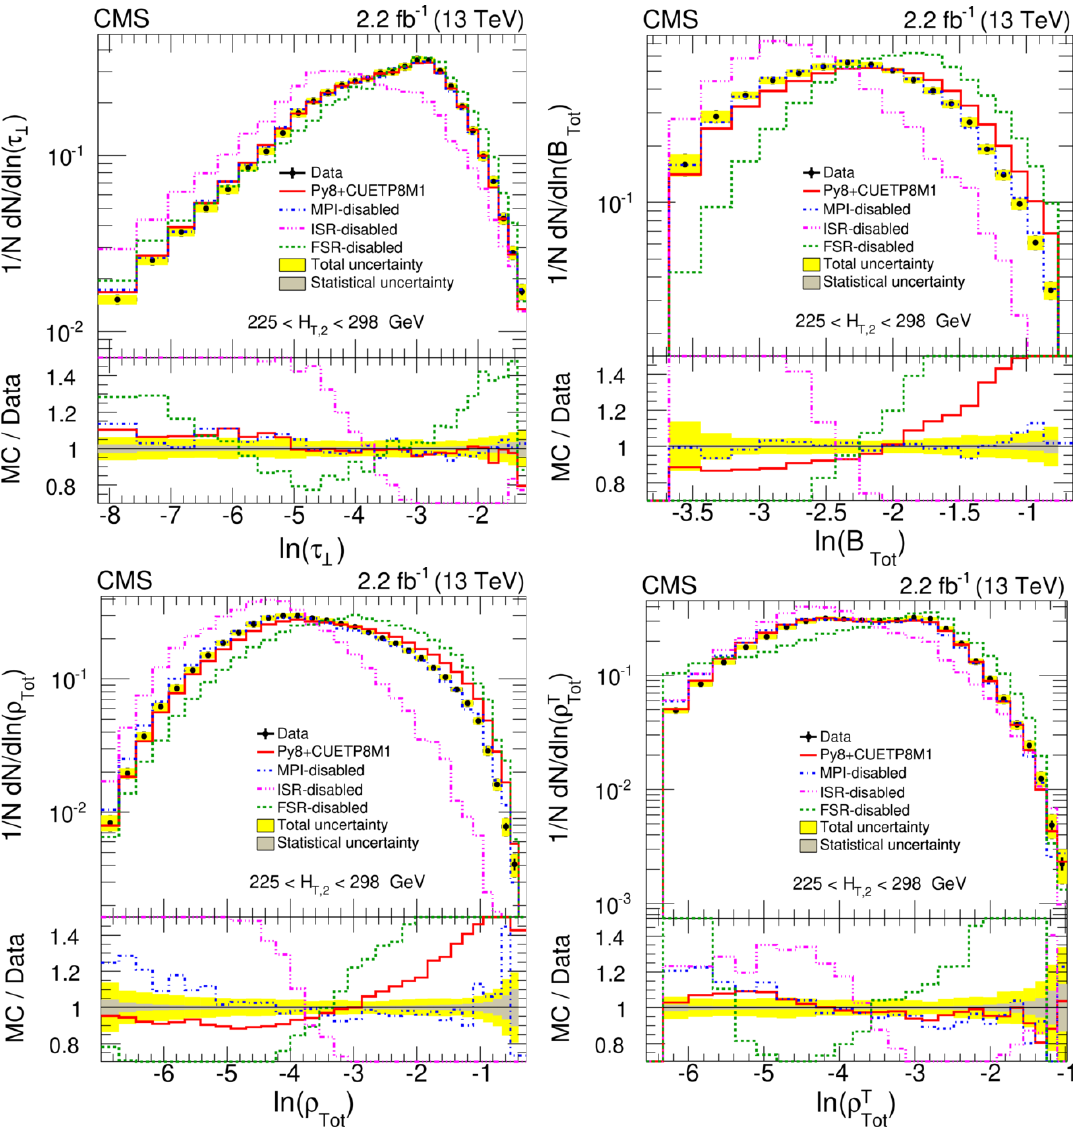
Figure 2 . The e(cid:11)ects of MPI, ISR, and FSR in pythia 8 CUETP8M1 on (cid:28) ? (upper left), B Tot (upper right), (cid:26) Tot (lower left) and (cid:26) T (lower right) for a typical range 225 < H T ; 2 < 298 GeV. Tot The ratio plots for simulation (MC) with respect to data are shown in the lower panel of each plot. The inner gray band represents the statistical uncertainty and the yellow band represents the total uncertainty (systematic + statistical) in each